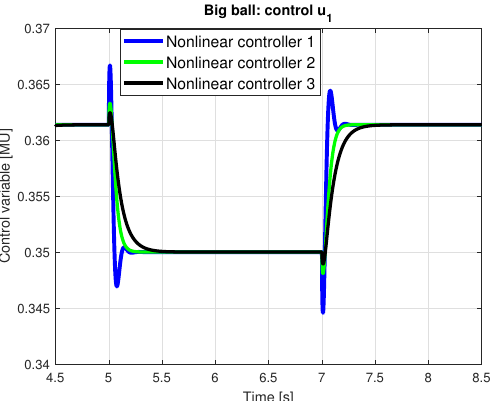
Figure 14. Big ball—control variable u : Simulation results for nonlinear control law, comparison of three variants of control parameters.